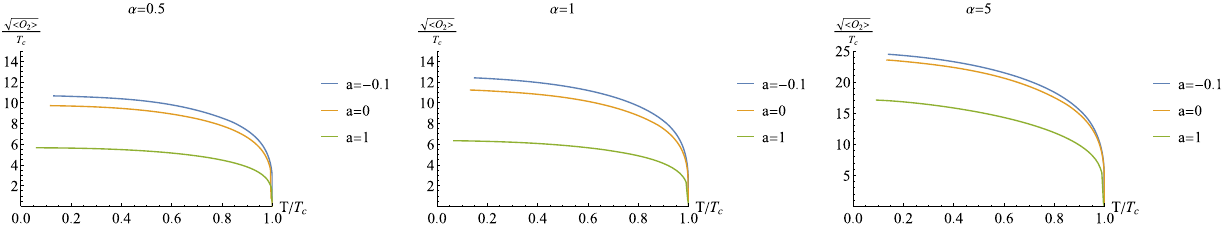
Fig. 4 The condensation < O 2 > as a function of temperature for given α (from left to right α = 0 . 5, α = 1 and α = 5) and various values of a . We have set q = 2 and n = 1. Here we have abbreviated the two dimensionless quantities { T /μ,α/μ } to { T ,α